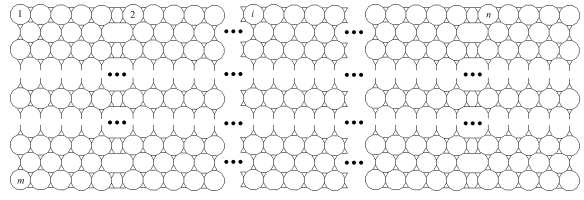
Figure 5: Paraline Graph of Multiple